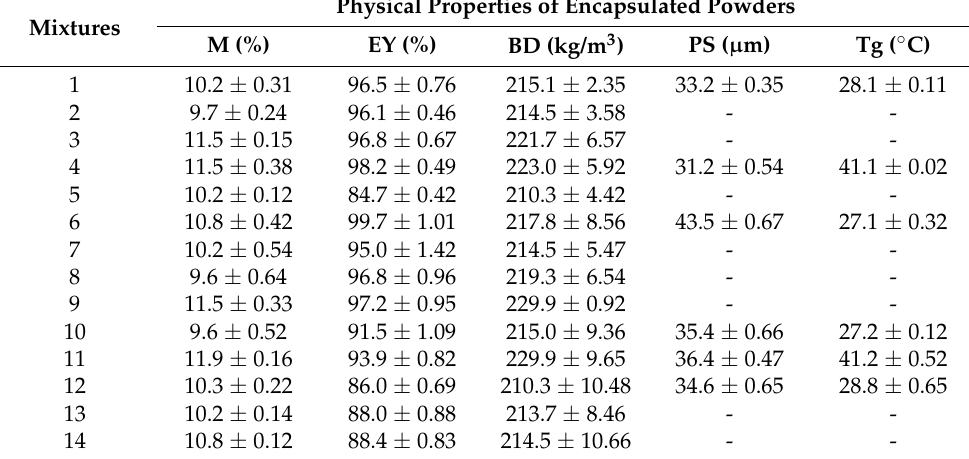
Table 2. Different wall material treatments based on mixture design to encapsulate onion extract and physical properties of encapsulated powders.